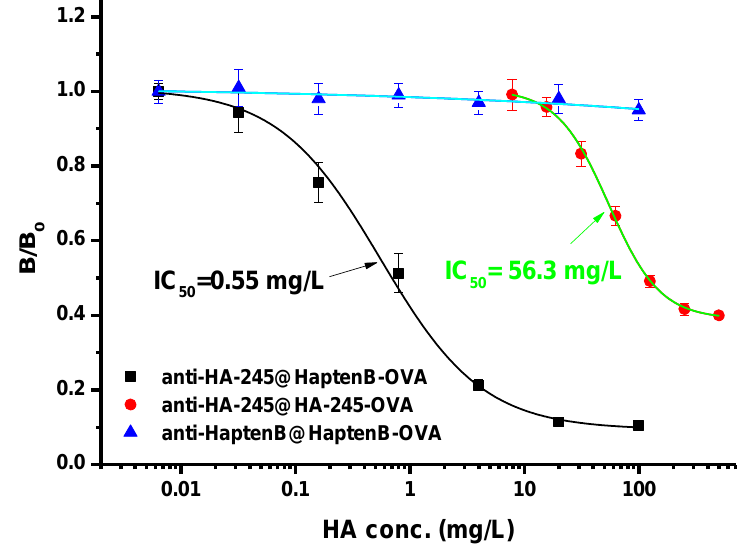
Figure 3. ic-ELISA inhibition curves of anti-HA-245#2 and anti-Hapten B#1 using Hapten B-OVA and HA-245-OVA as coating antigen, respectively.